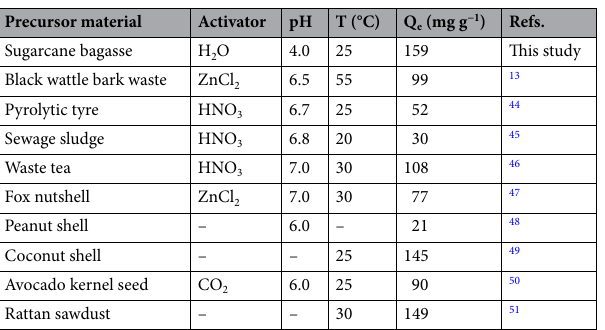
Table 3. Comparison between SD_AC_H 2 O and other activated carbons used for phenol adsorption.